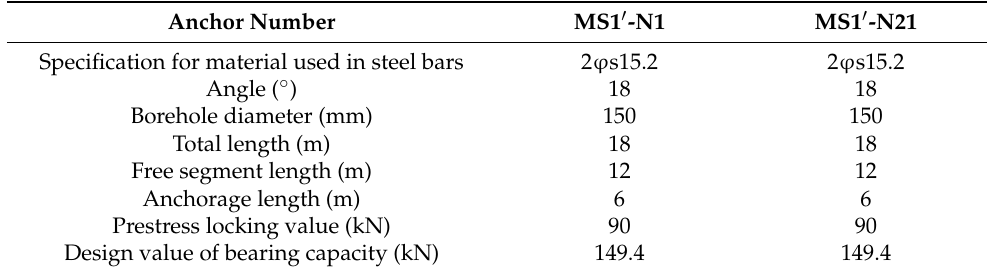
Figure 7. Anchorage construction section. Table 1. Test anchor cable